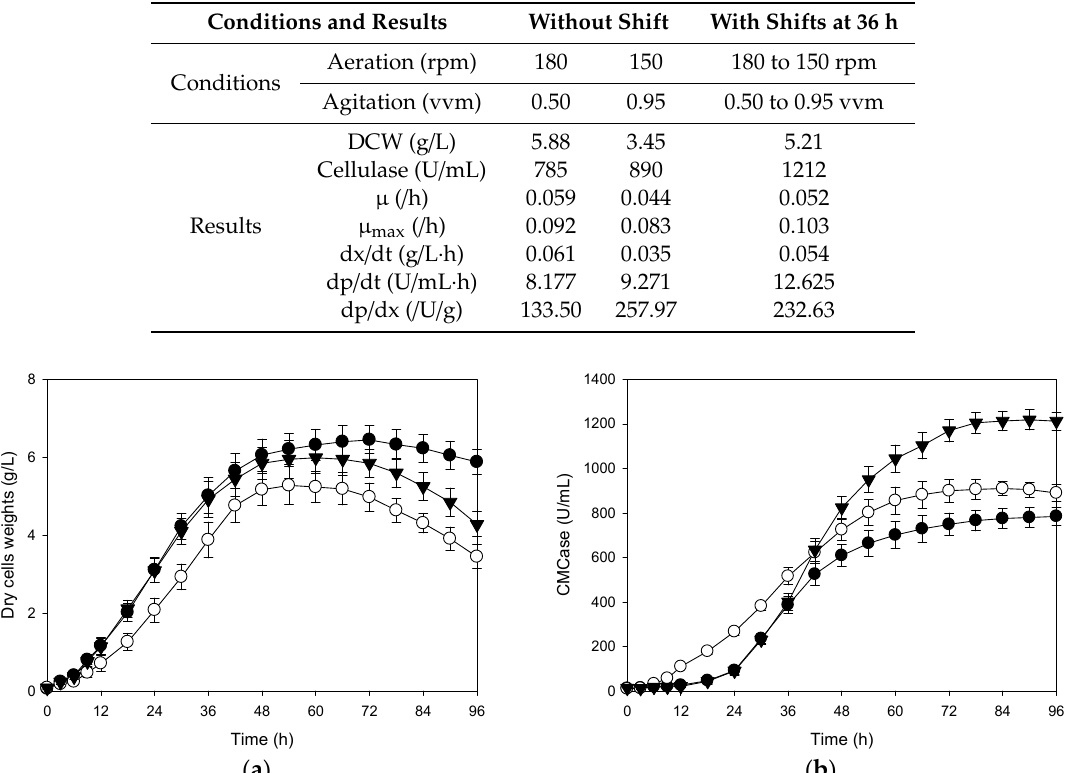
Table 2. Comparison of cell growth and production of CMCase by E. coli KACC 91335P in a 100 L bioreactor.